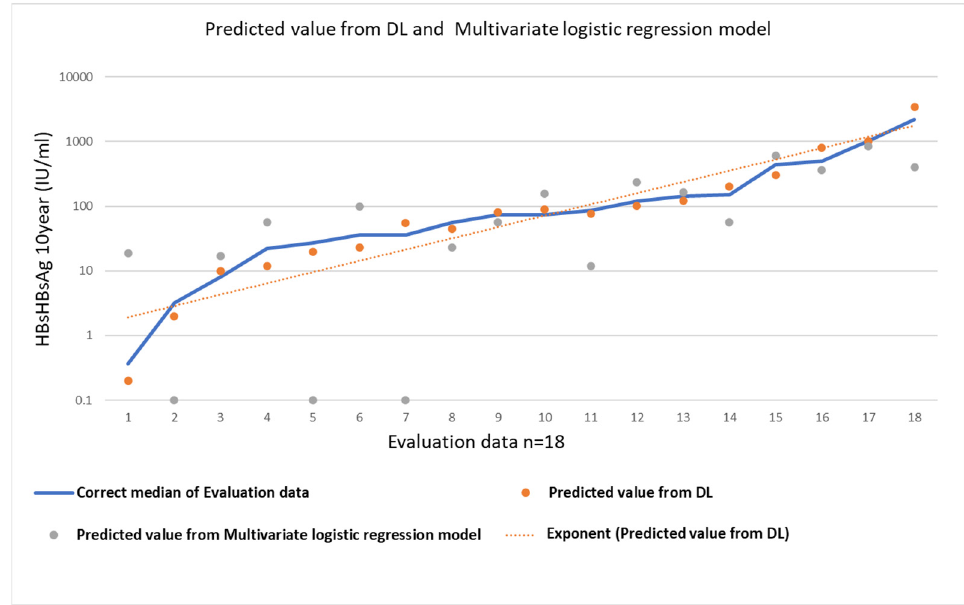
Figure 5. Evaluation table. The correct median of the evaluation data and the predicted value from DL and multivariate logistic regression